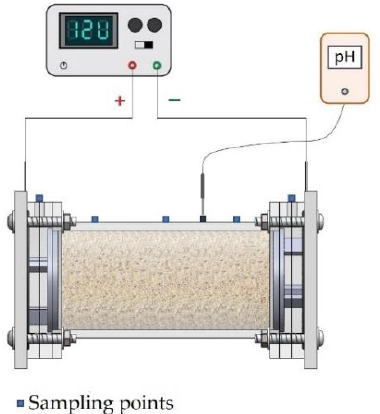
Figure 1. The experimental apparatus used for the electromining of the synthetic and real soil (adapted from Pires et al. [19]).